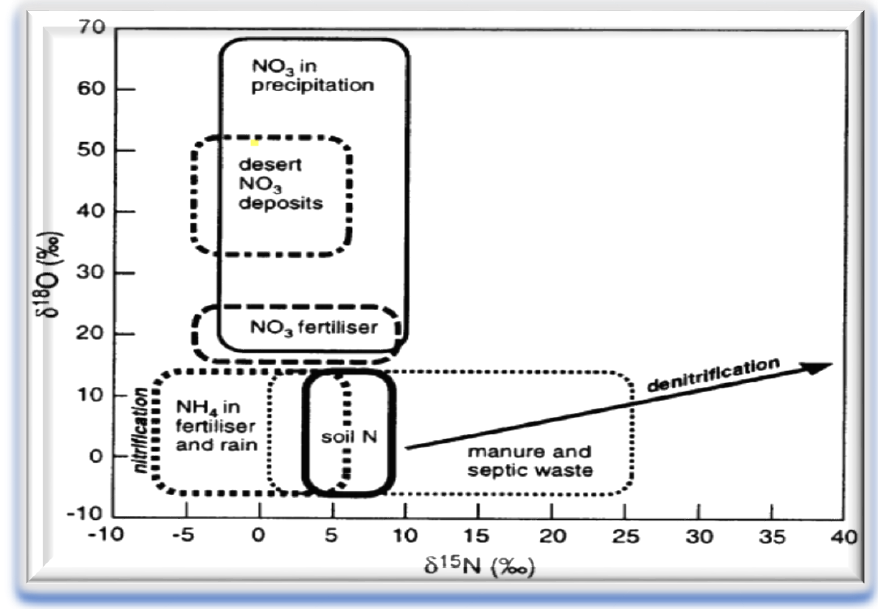
Figure 3. Typical values of δ 15 N and δ 18 O of nitrate derived from various N sources [54]. On the other hand, since denitrification involves the reduction of NO 3− (terminal electron acceptor) to N 2 , the concentration of the residual NO 3− will be negligible com- pared to that of the substrate pool. Therefore, increase in denitrification will lead to an increase in δ 15 N and δ 18 O values with an exponential decrease in nitrate concentration. This observation is, in principle, congruent with the study of [55] where samples taken from farming and animal-rearing areas as well as bad sanitary zones in Ghana had en- riched δ¹⁵N − NO 3 and δ¹⁸O − NO 3 (in the ratio of 2:1) values with a corresponding de- crease in NO 3− concentration due to the denitrification effect.